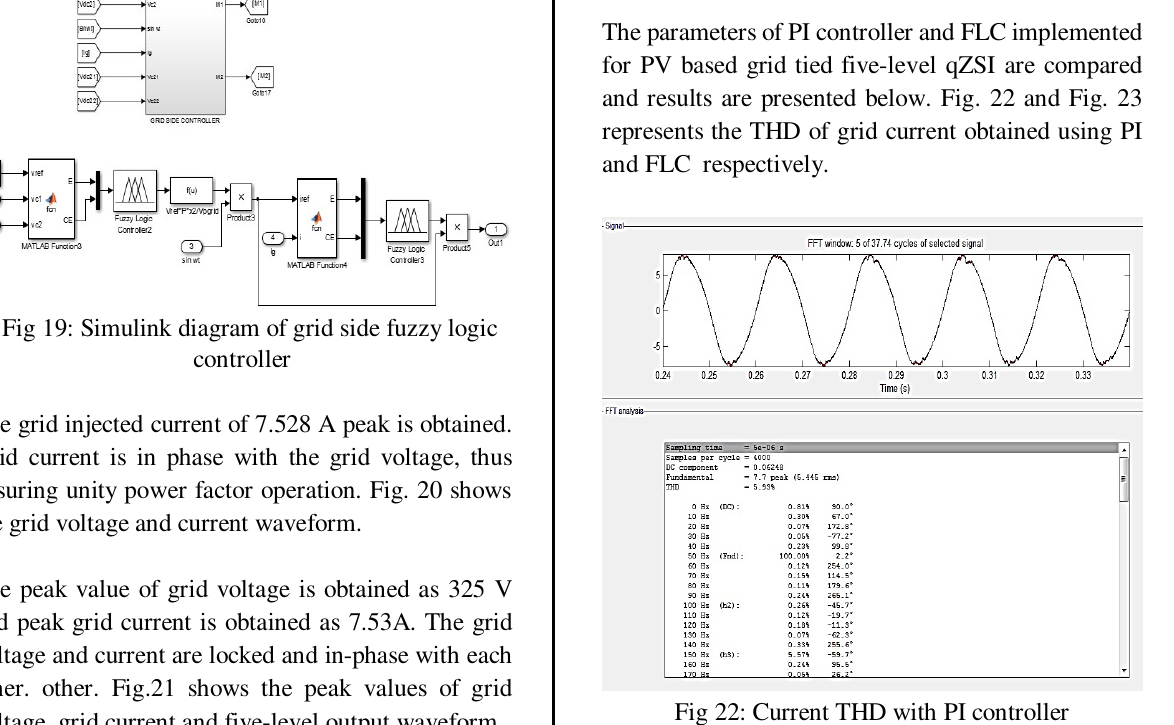
Fig 22: Current THD with PI